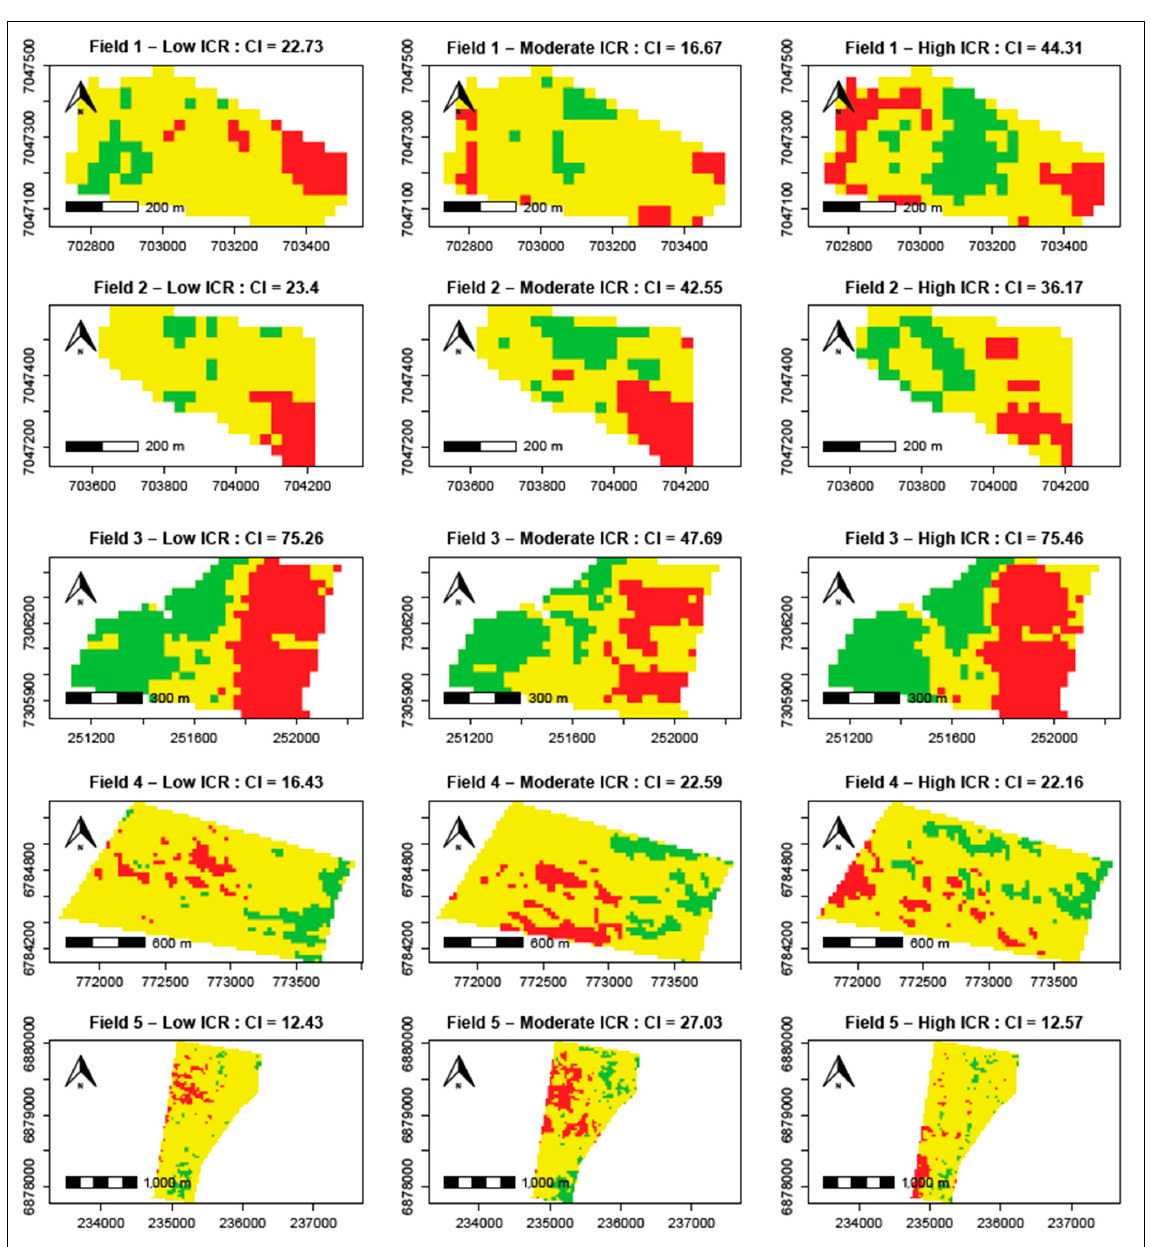
Figure 5. Consistency maps for all five fields in low, moderate and high ICR years. Green = consistently high, red = consistently low, yellow = inconsistent/moderate.